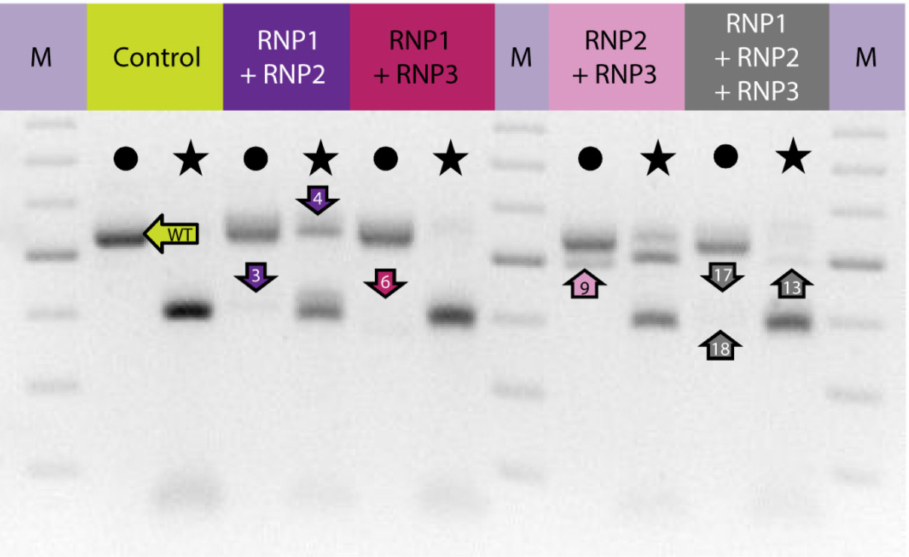
Figure 2. The carrot F3H gene fragment before and after delivery of RNP complexes in different combinations to PEG-treated protoplasts. Lanes with the WT 538 bp fragment amplified by PCR are marked by dots while lanes with products after incubation with Nco I endonuclease recognizing the restriction site at the gRNA2 target site are marked by stars. Arrows indicate products that were sequenced. M—GeneRuler DNA Ladder Mix (Thermo Fisher